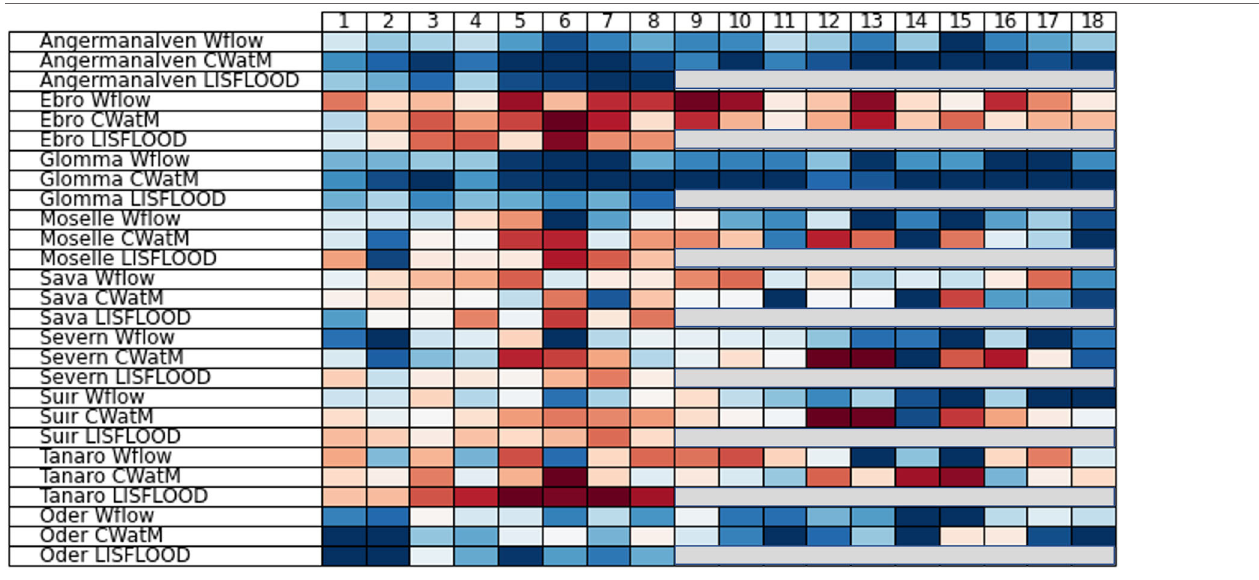
TABLE 5 | Projected change in long-term average 7-day minimum low flow between the periods 1981–2010 and 2031–2060.